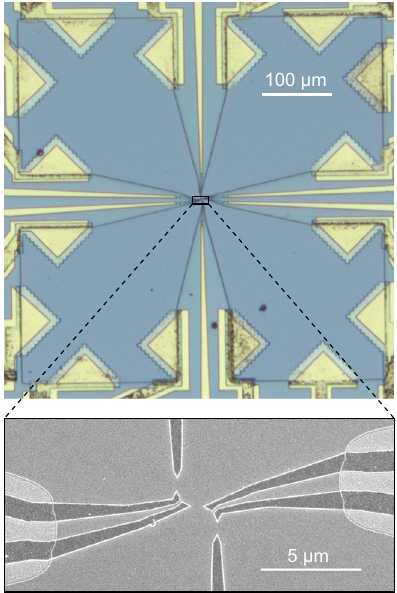
Fig.5|Large-scalesamplepictures. Optical(top)andSEM(bottom)imagesofthe measured